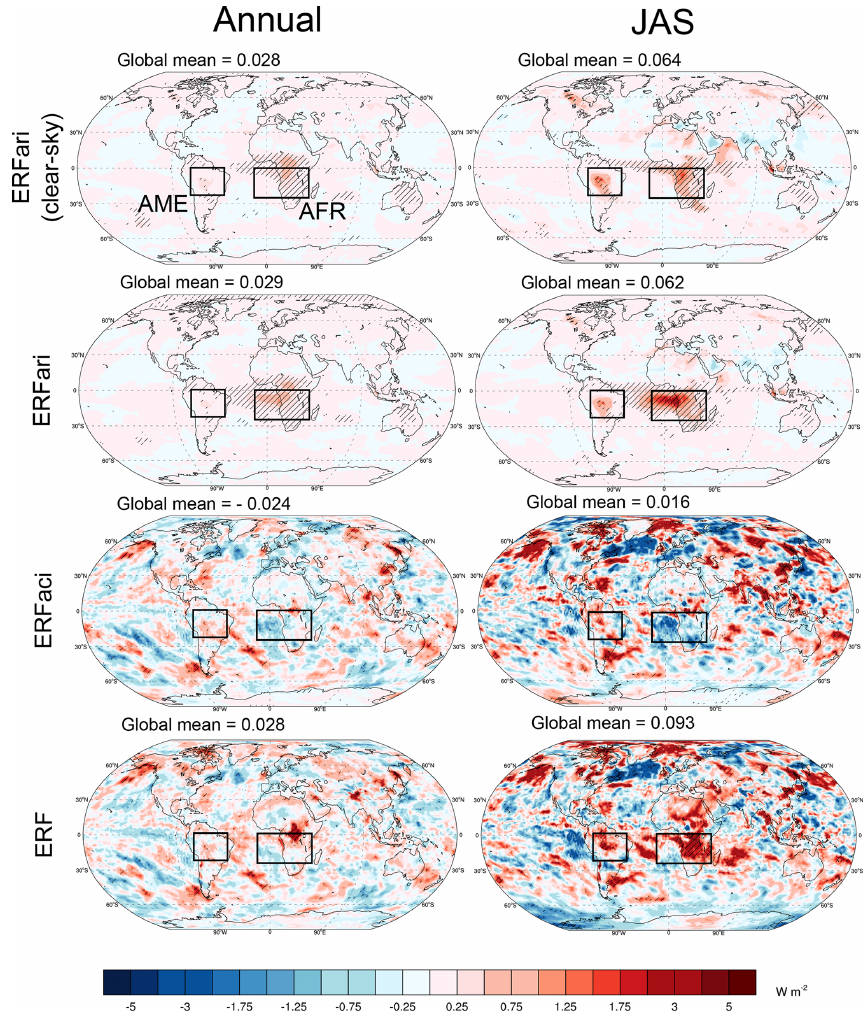
Figure 12. BrC ERF ari (Wm − 2 , clear-sky and all-sky conditions) and ERF aci (Wm − 2 , all-sky conditions) and the sum of both (ERF ari + ERF aci , Wm − 2 , all-sky conditions) averaged over the year and over JAS. Hatching indicates regions with a significant effec- tive radiative forcing at the 0.05 level (Wilks